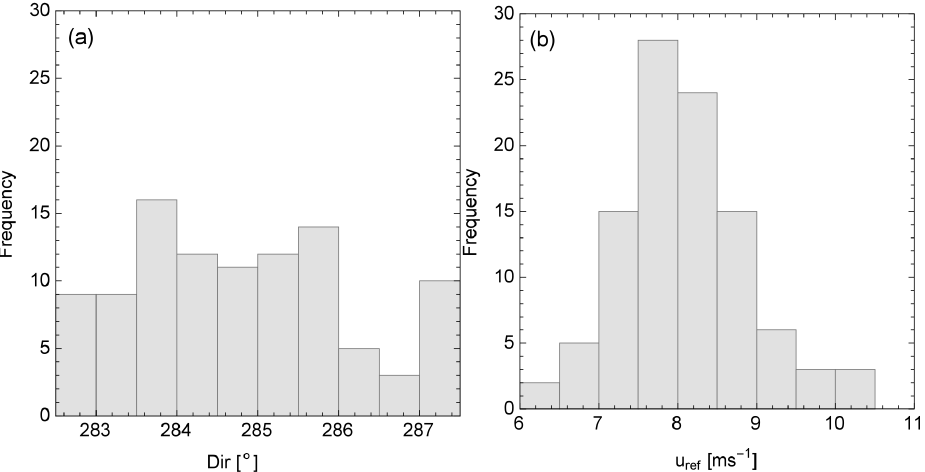
Figure A2. Histograms of the 26s mean wind speed (a) and direction (b) over those periods when the mean wind direction was within the 282.5–287.5 ◦ sector. The measurements were acquired by the sonic anemometers located on the M 1 mast, at 4.0m above ground